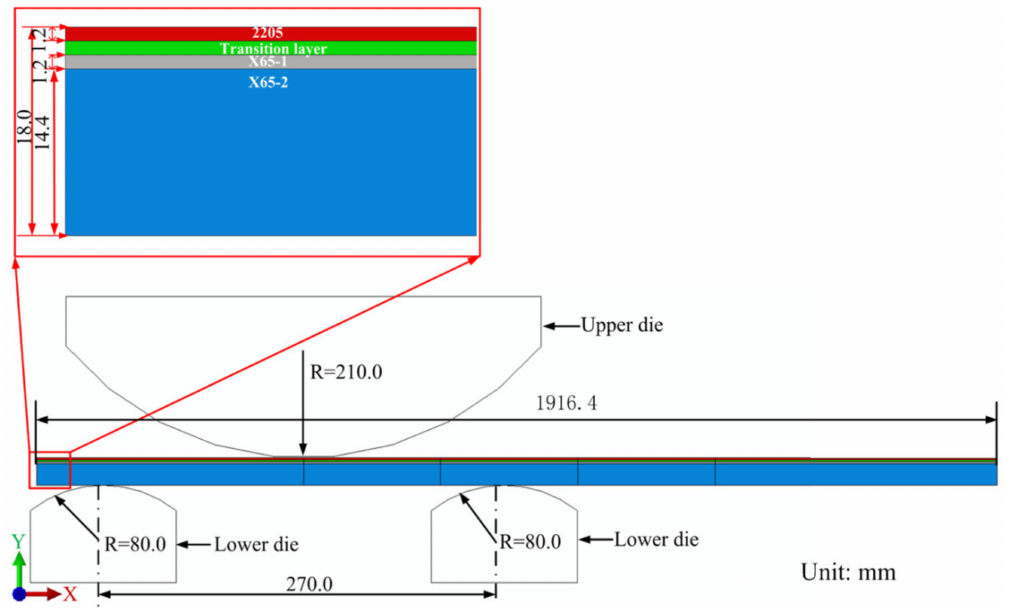
Figure 18. Two-dimensional (2D) finite element model for the JCO forming.